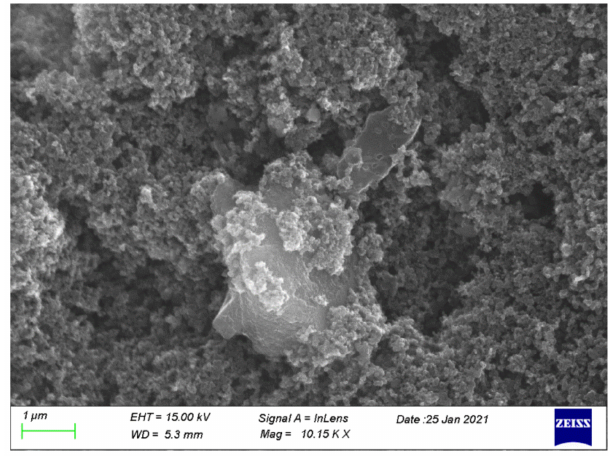
Figure 9. FESEM image of the surface of an Na–BC-carbon black film deposited on carbon cloth. The specific capacitance of such electrodes was measured by making symmetric cells supporting two identical electrodes and filled with the same electrolyte as that used to run the photocatalytic fuel cell, i.e., 0.5 M aqueous NaOH containing 5% v/v ethanol (see Sections 2.4 and 3.3). Figure 10 shows the diagram used to measure the specific capacitance of the Na–BC electrode. The capacitance was calculated by the formula C = 2 × I × t/V, where I is the (constant) discharge current, V the maximum voltage and t the discharge time.